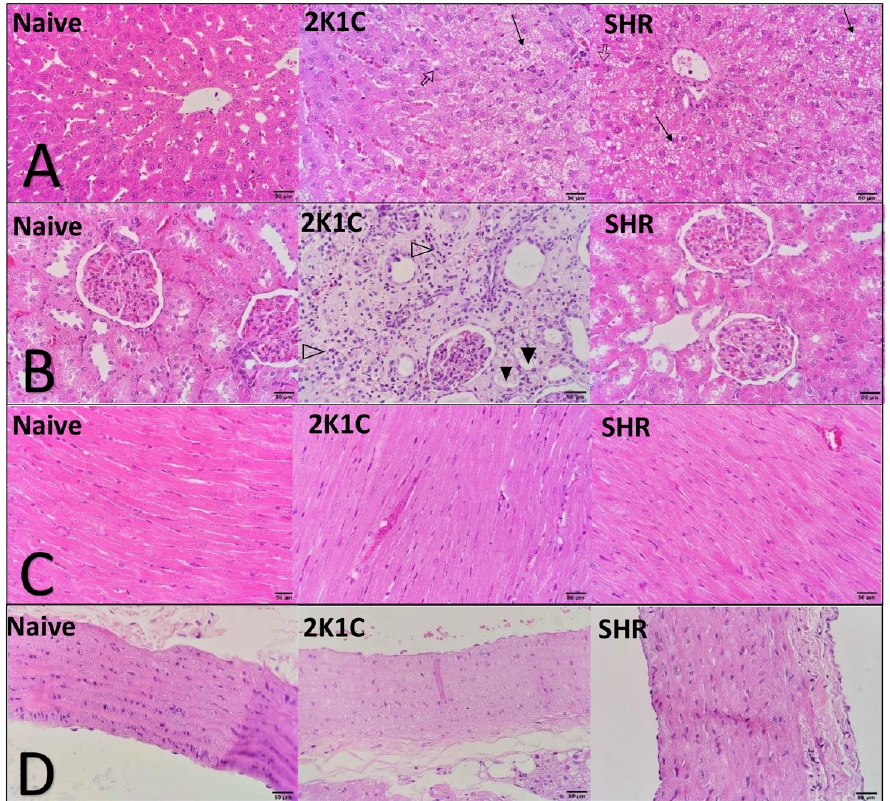
Figure 3. Representative histological sections of the liver ( A ), kidney ( B ), heart ( C ), and aorta artery ( D ) from normotensive and hypertensive high ‐ fat ‐ fed rats. The black arrows show micro and macro vacuolization and diffuse swelling of the hepatocyte’s cytoplasm. Empty ‐ core arrows show necrosis in the liver. Empty ‐ core arrowhead shows interstitial mononuclear inflammatory infiltrate. The black arrowhead shows thickening of the renal capsule in the remaining corpuscles and multifocal areas of calcification. H&E (40×). 2K1C: two ‐ kidney ‐ one ‐ clip hypertension; SHR: spontaneously hypertensive rats.